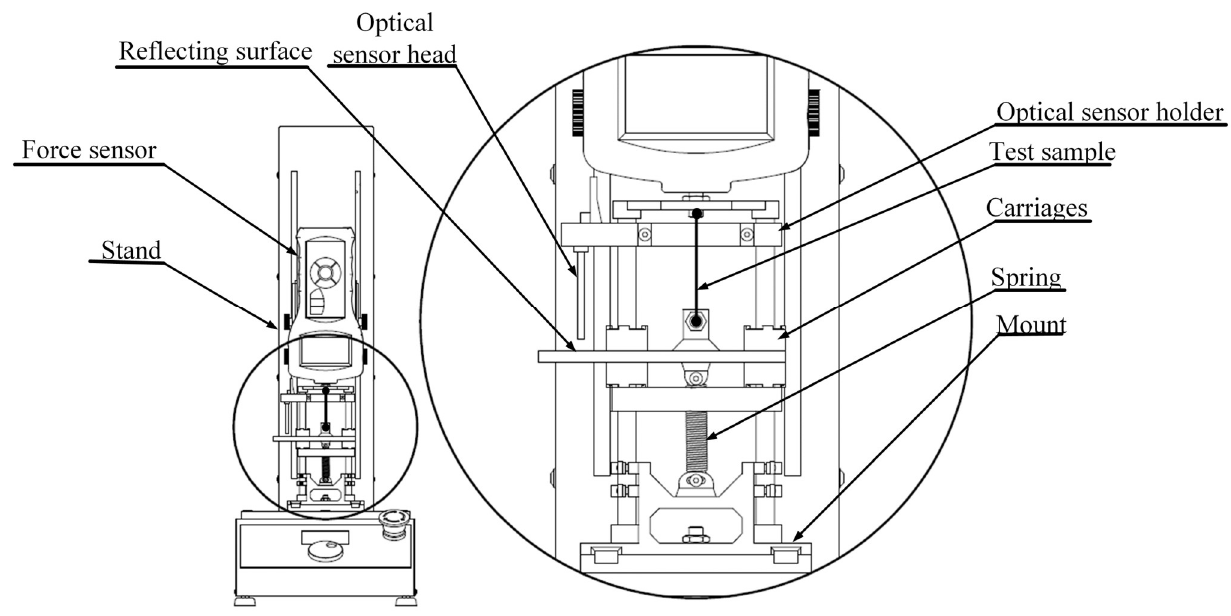
Figure 1. Scheme of the test stand.